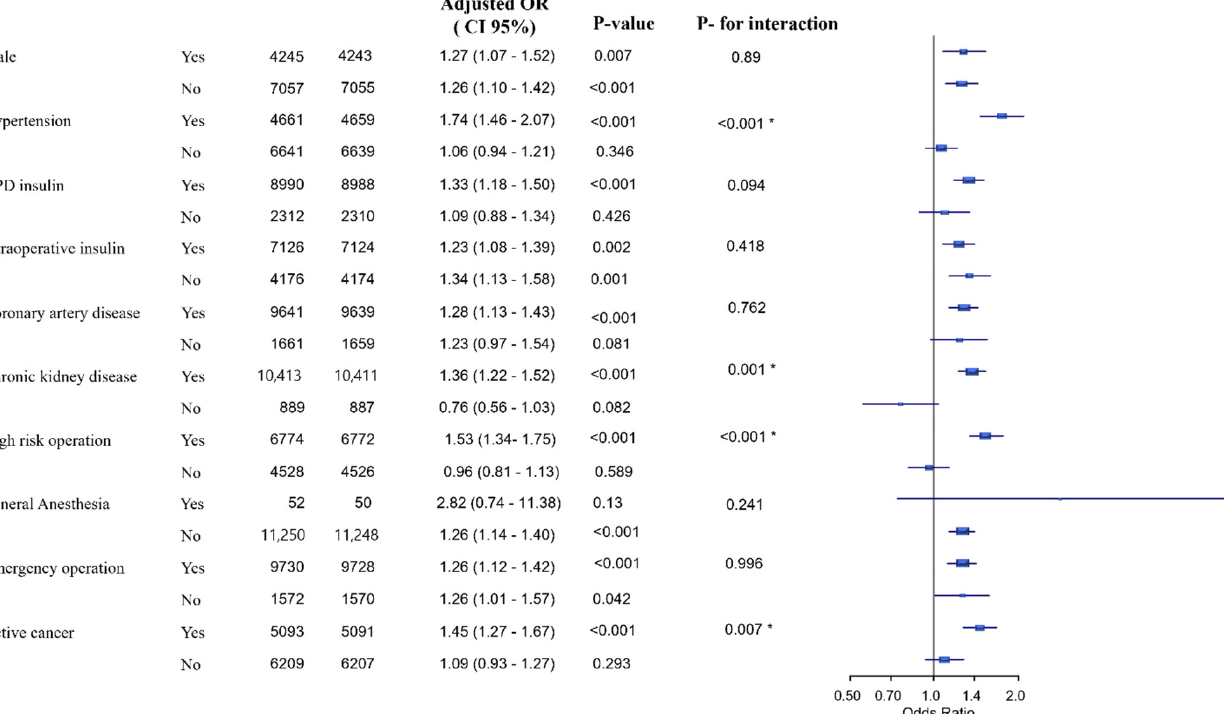
Figure 2. Forest plot from subgroup analysis showing the association between significant hyperglycemia and risk of MINS. * p - for interactions for these variables are significant ( p < 0.005).